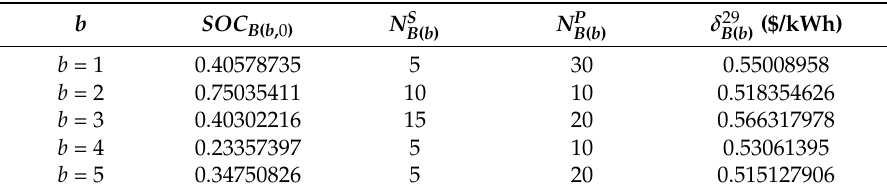
Table 5. Characteristics of distributed BESS.